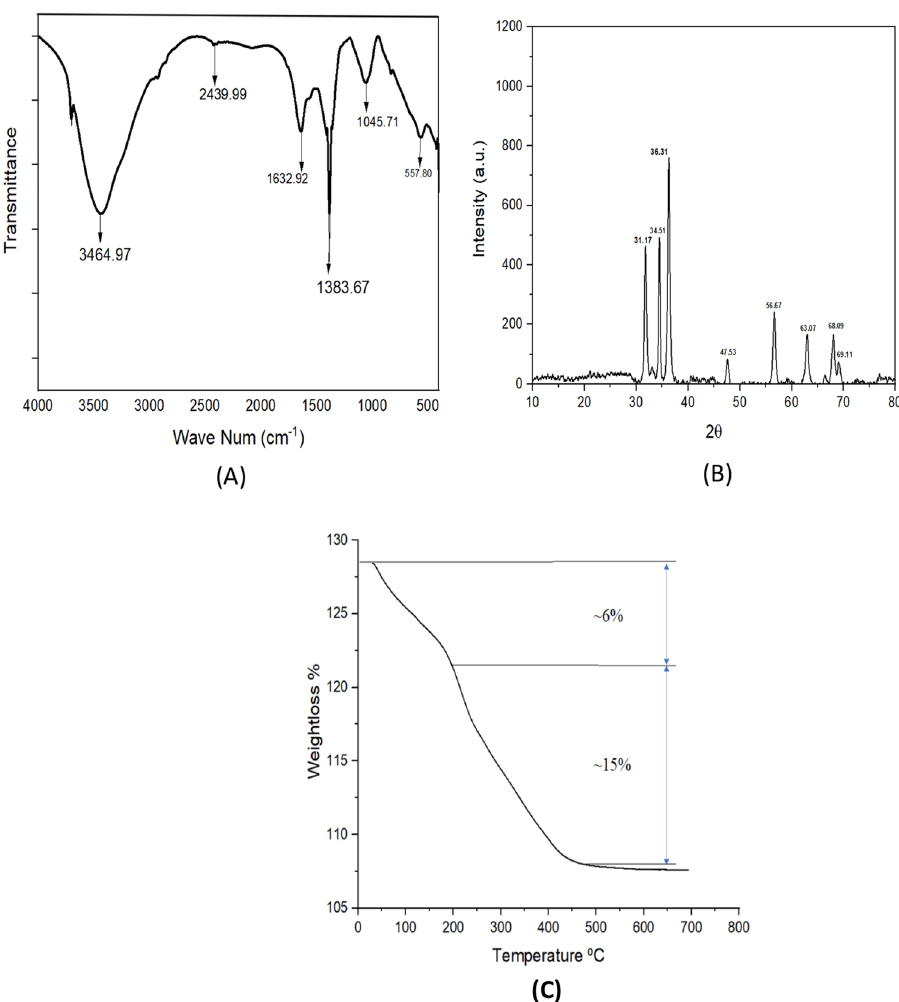
Figure 3. ( A ) FTIR spectra of ZnONps. ( B ) XRD analysis of the synthesized ZnONps. ( C ) Thermogravimetric analysis of synthesized ZnO